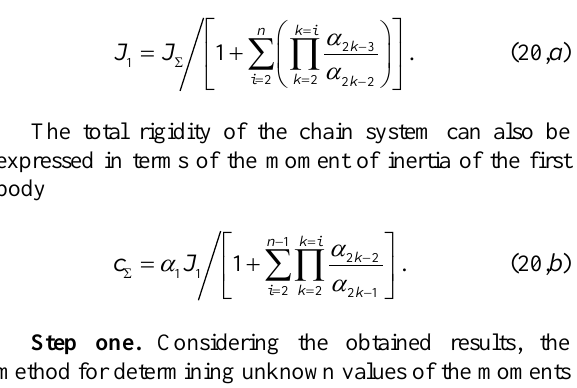
Table 1. Relationship between the indices of the squares of partial frequencies, moments of inertia and